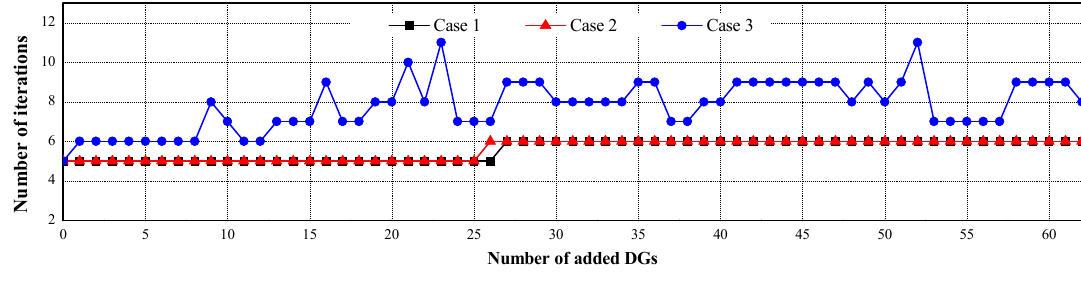
Figure 12. Numbers of PV buses and bounded PQ buses for Case